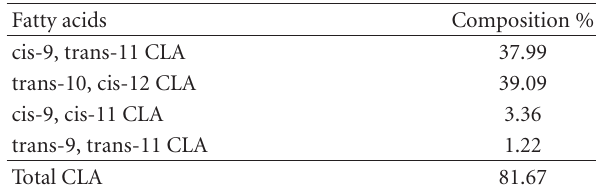
Table 2: Major fatty acid composition in